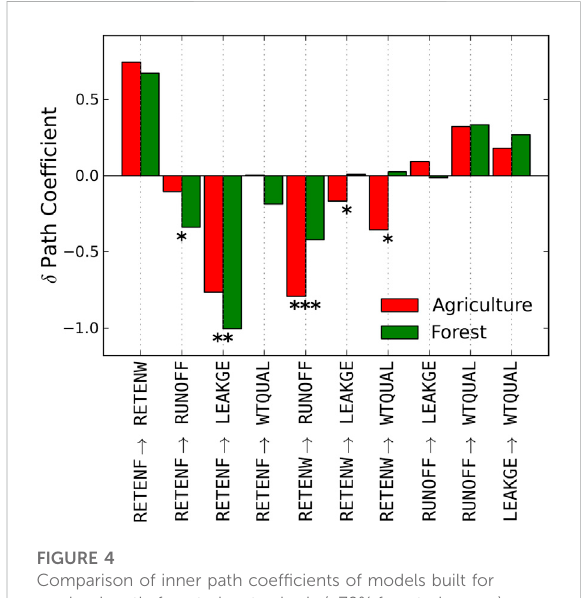
FIGURE 4 Comparison of inner path coef fi cients of models built for predominantly forested watersheds ( > 70% forested, green) vs . more agricultural ones (red). * p < 0.05, ** p < 0.01, * p < 0.001.